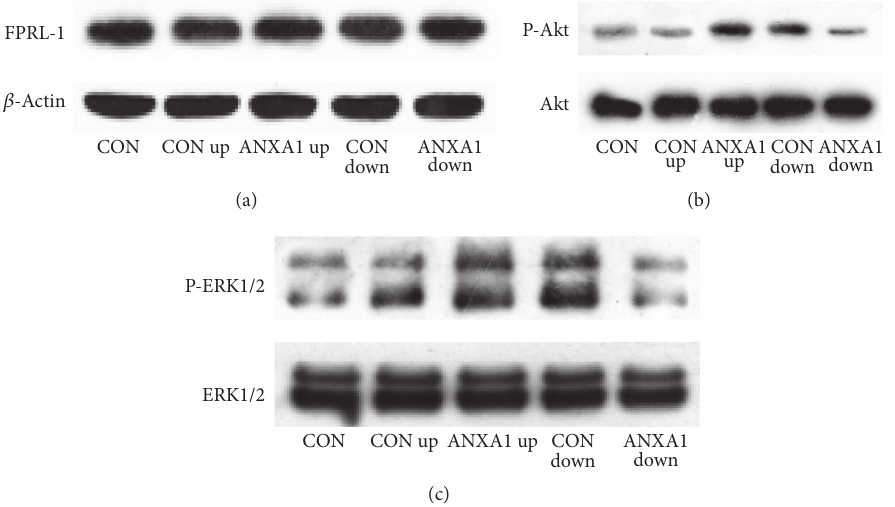
Figure 4: ANXA1 modulates GATA-3 expression through ERK and AKT pathway. CD4 + T cells were infected with ANXA1 up or ANXA1 down Lentivirus in Th0 condition and then stimulated with anti-CD3/CD28 (5.0 𝜇 g/mL) for 8 h to analyze FPRL-1, ERK, and Akt expression by western